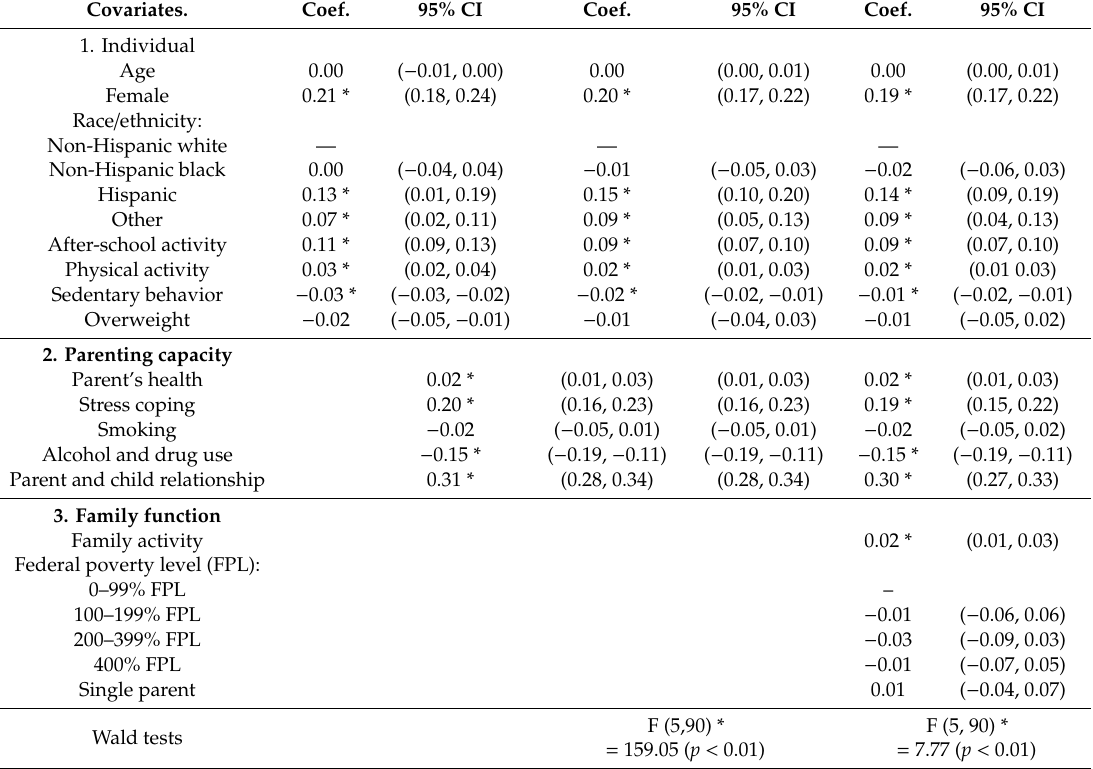
Table 2. Sequential regression of the children’s flourishing with